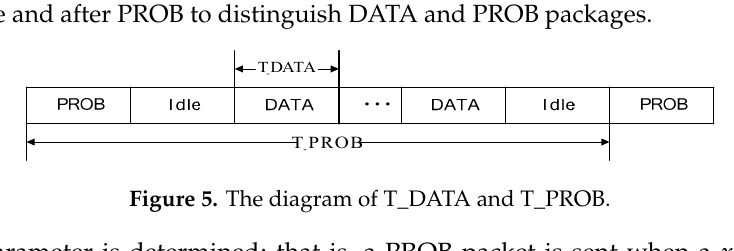
Algorithm 1 ． Choose CN ( m n , m v , t , KCN R